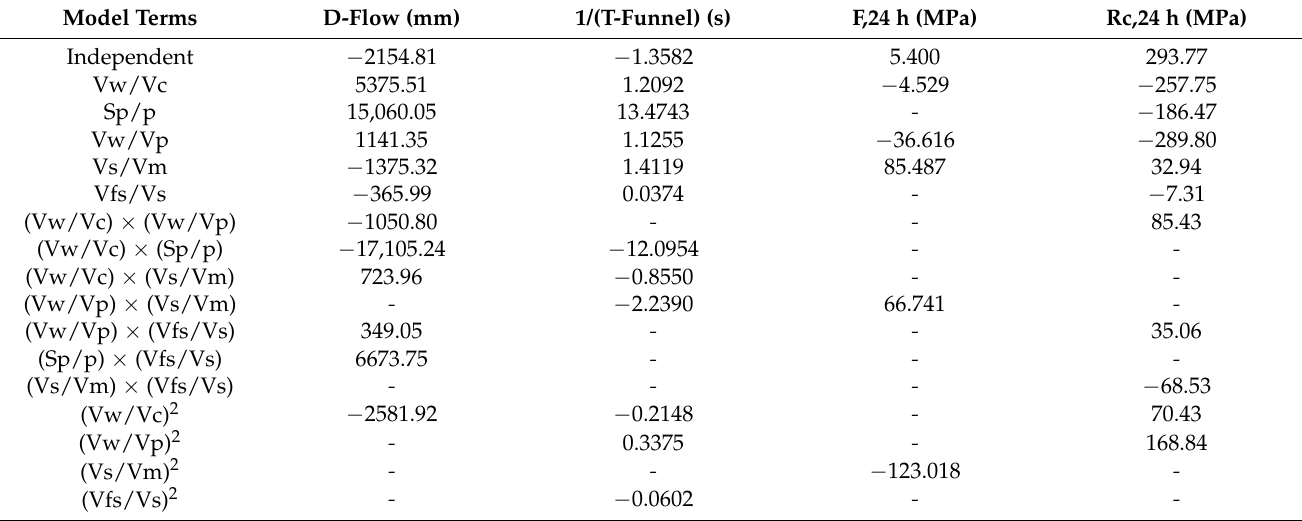
Figure 8. Influence of each factor on fresh state responses, in which (+) Positive effect in response models; ( − ) Negative effect in response model (see Table 13). Table 13. Final equations in terms of actual factors: estimated